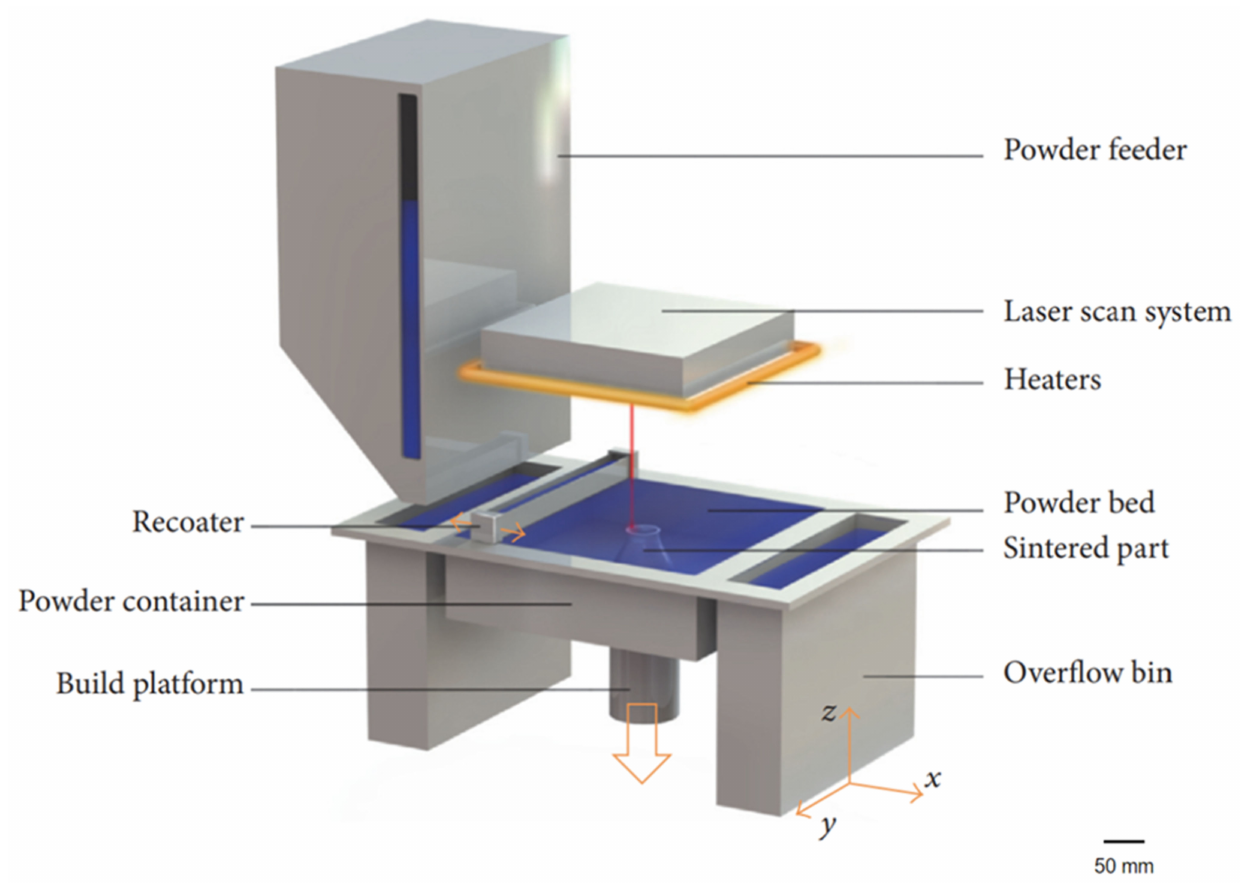
Figure 3. Schematic illustration of a typical laser sintering system. Scale bar = 50 mm. Reprinted with permission from